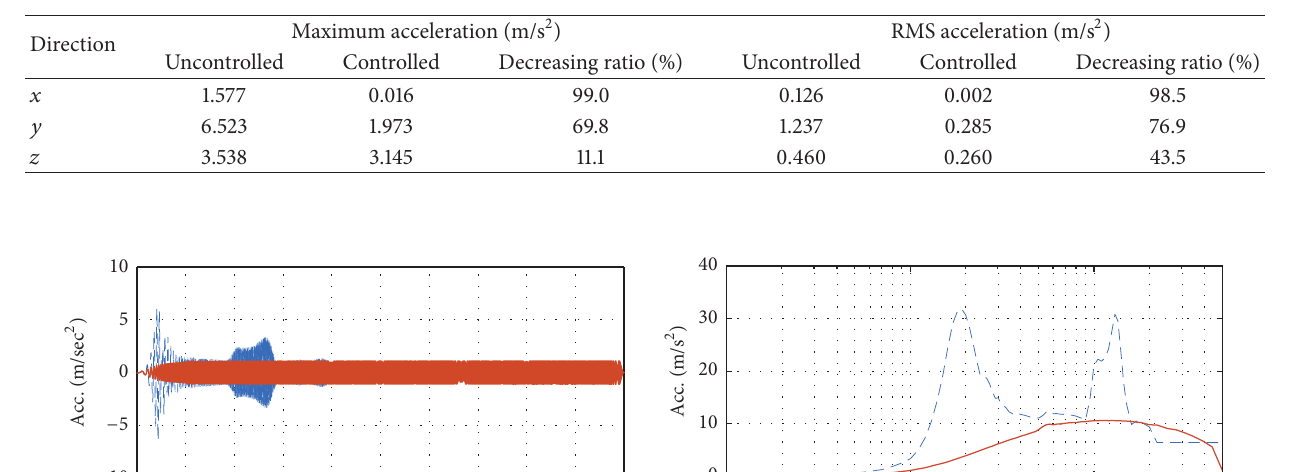
Table 5: Results for El Centro earthquake.